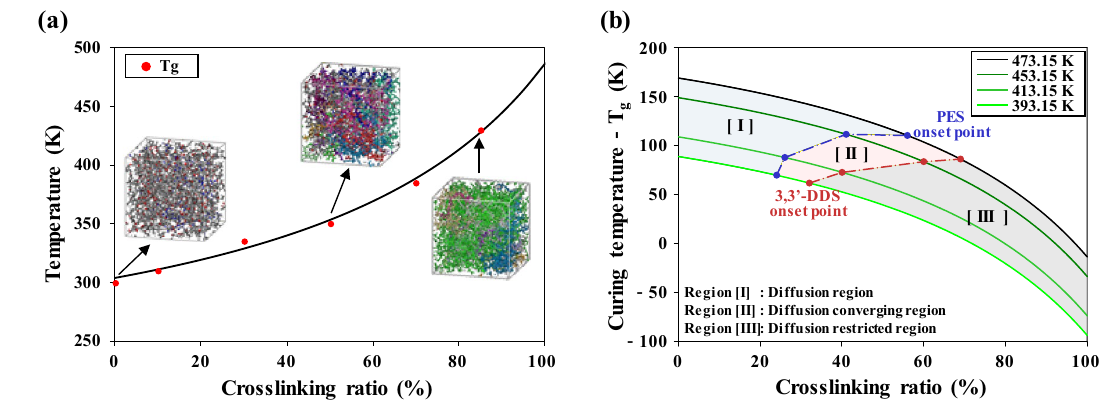
Figure 6. ( a ) Glass-transition temperature ( T g ) of the epoxy system as a function of the crosslinking ratio. The red dots represent the calculated T g values, and the black line represents the fitting data. ( b ) Difference between the curing temperature and the T g , along with onset points of 3,3 ′ -DDS and PES, for different curing